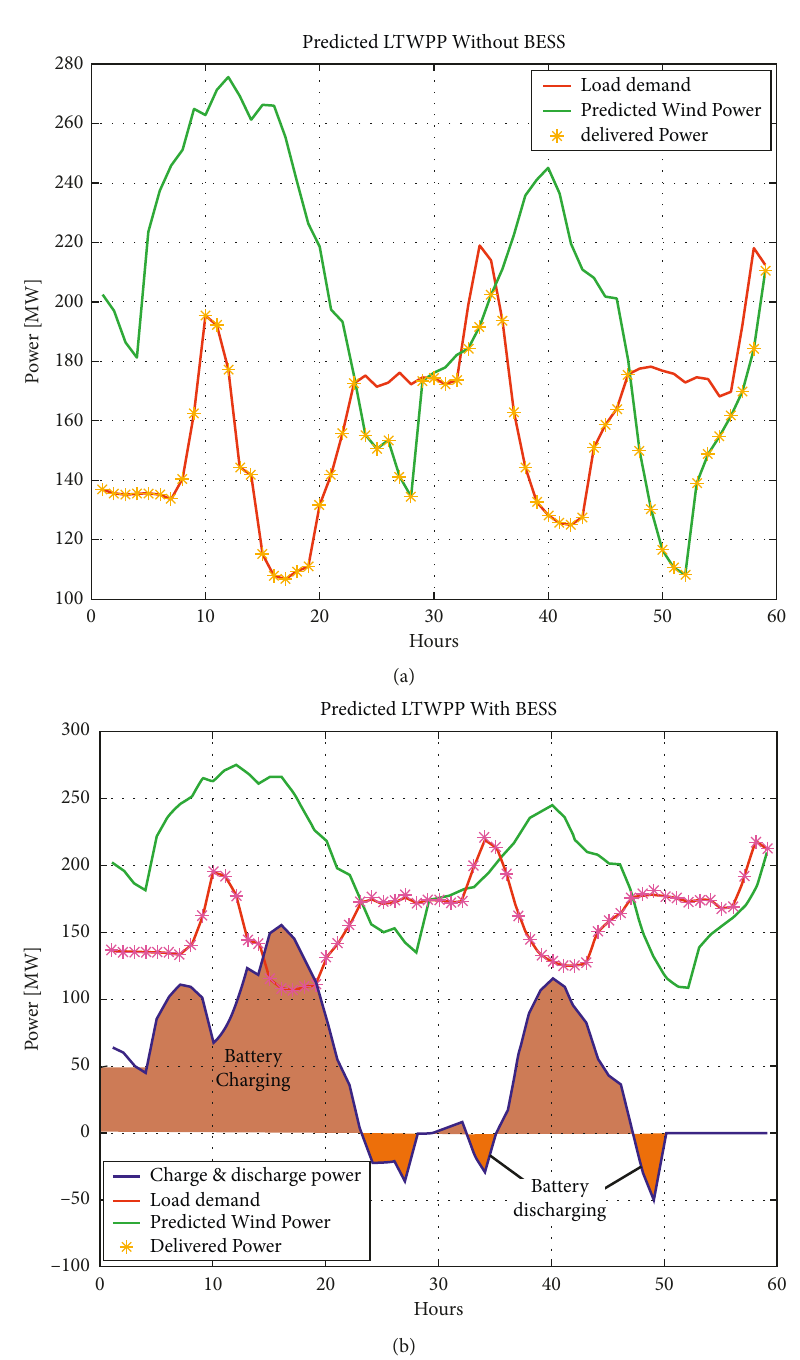
Figure 15: (a) Predicted LTWPP output power without BESS. (b) Predicted LTWPP with BESS.